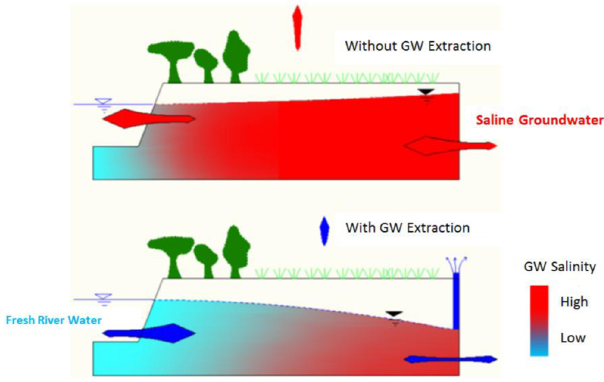
Fig. 16. Conceptual model of the impacts of groundwater extraction on salinization risk in a semi-arid